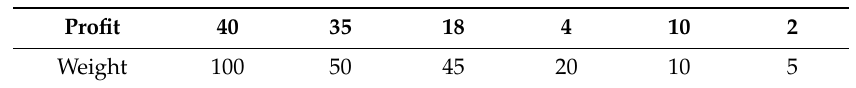
Table 1. 0 / 1 knapsack